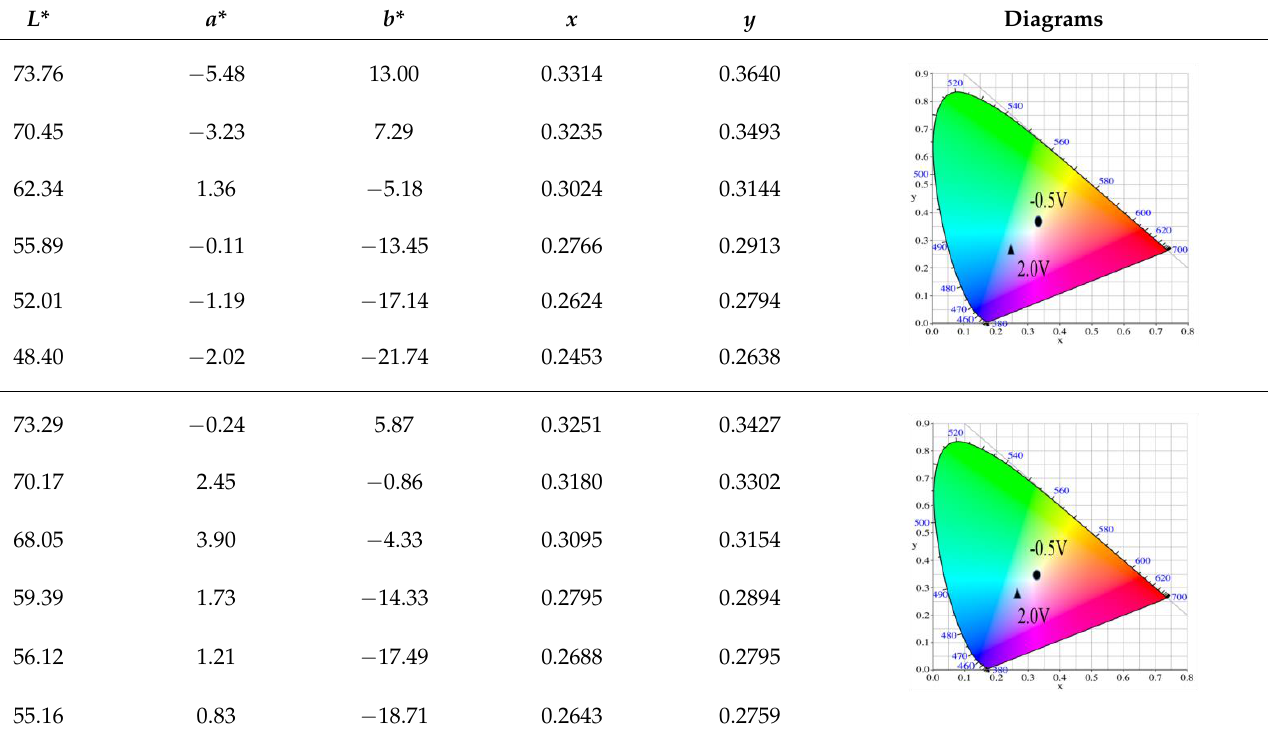
Table 5. Electrochromic photographs, colorimetric values ( L *, a *, and b*) and CIE chromaticity values ( x , y ) of (a) PDTC/PE- Photographs